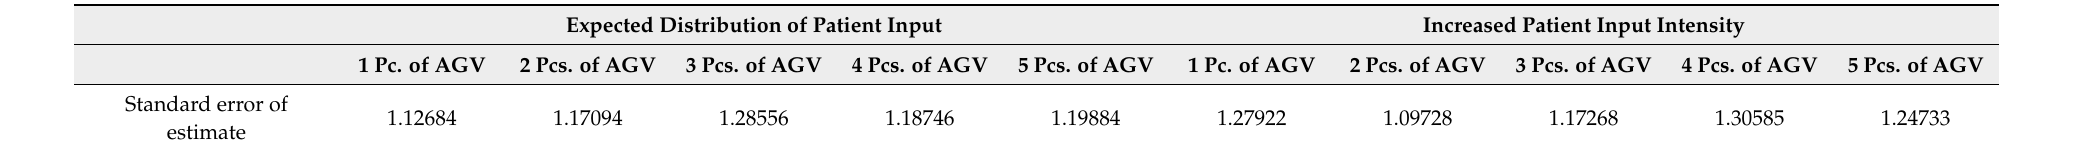
Table 4. Estimation error of realised simulation experiments for disinfection with patients in locations.